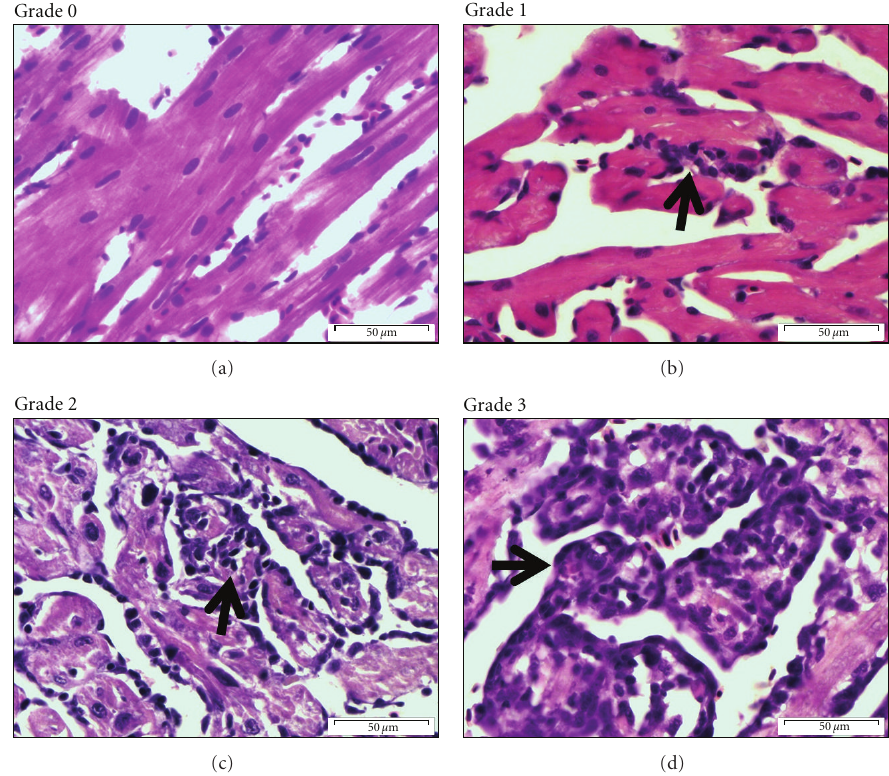
Figure 1: The representative micrographs of the semiquantitative scoring system described in Table 1, represented the heart histopathology. Grade 0: no pathological changes. Grade 1: minor inflammatory lesions comprises of focal subendocardial mononuclear leukocytes. Grade 2: several distinct lesions with moderately increased number of mononuclear leukocytes. Grade 3: severe lesions where almost all myofibres have been replaced by inflammatory cells, predominantly by mononuclear lymphocyte-like cells. Arrow: inflammation. Scale bars = 50 µ m. Table 2: Total mean ( ± SD) scores of inflammation and necrosis for HSMI (groups 1, 2, and 3), CMS (group 4), and nondiseased fish (groups 5, 6, and 7) in heart and heart with skeletal muscle. Di ff erent letters represent significant di ff erences between groups ( P < 0 . 05). Parameter Nondiseased HSMI CMS Inflammation Heart 0 . 83 ± 0 . 30 5 . 30 ± 1 . 16 2 . 44 ± 1 . 39 Heart + muscle 0 . 99 ± 0 . 16 a 5 . 59 ± 1 . 03 b 2 . 44 ± 1 . 39 c Necrosis Heart 0 . 35 ± 0 . 36 2 . 01 ± 1 . 34 0 . 1 ± 0 . 40 Heart + muscle 0 . 62 ± 0 . 45 a,c 2 . 92 ± 1 . 15 b 0 . 38 ± 0 . 68